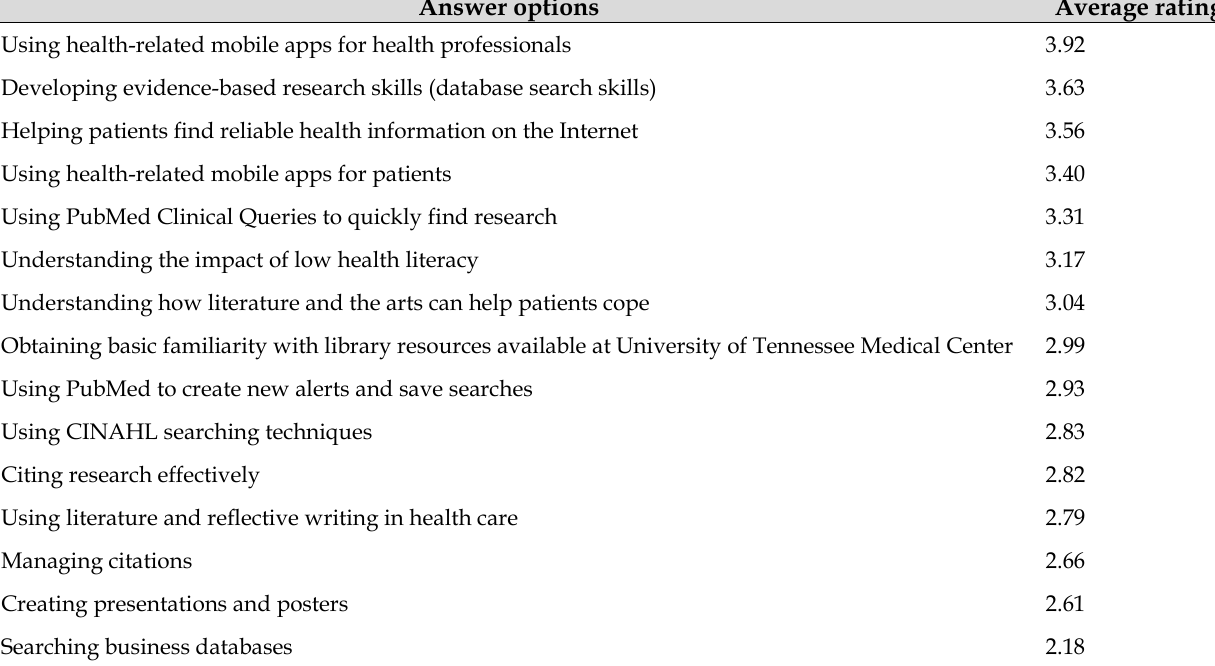
Table 1 Rankings of topics/skill areas (1=low value/interest, 5=high